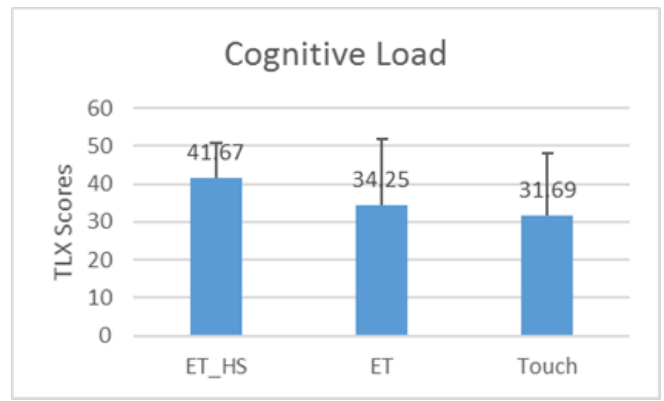
Figure 18. Comparing cognitive load in terms of average TLX scores.